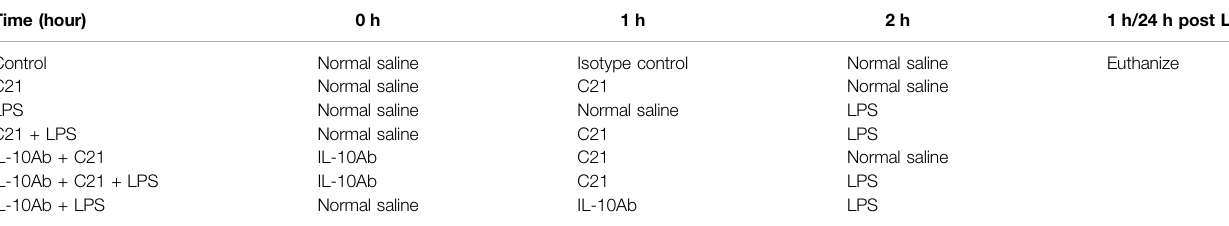
TABLE 1 | Summary of treatments at different time points (Protocol 3 and 4). Time